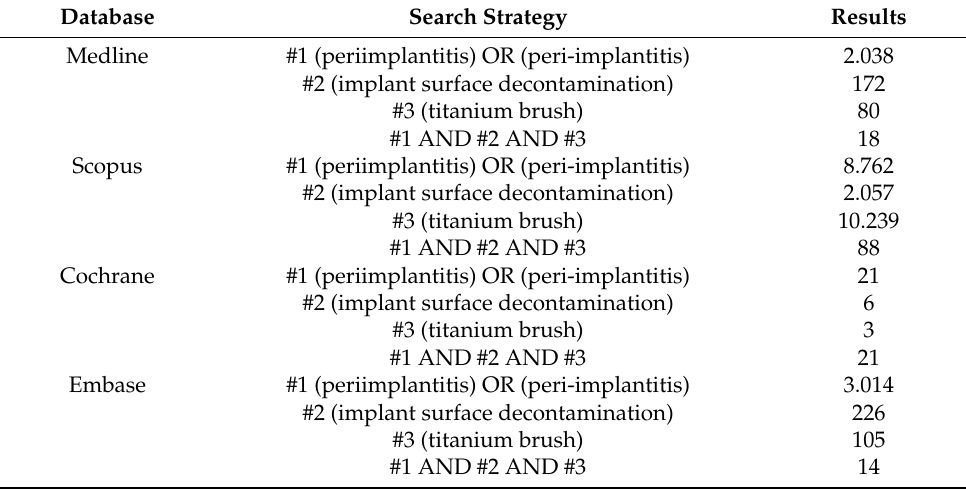
Table 1. Search Strategy and results by